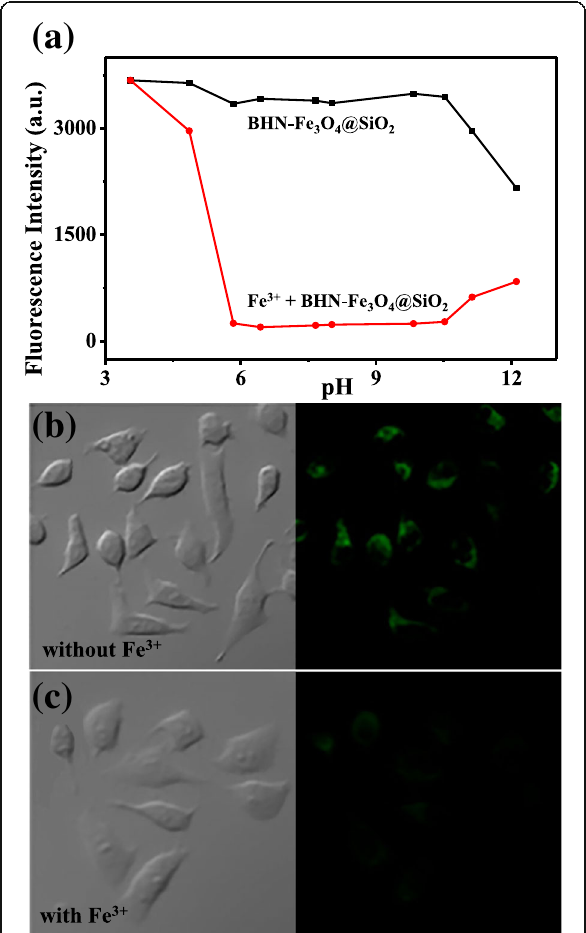
Fig. 5 a Fluorescence intensities of BHN-Fe 3 O 4 @SiO 2 and Fe 3+ -BHN- Fe 3 O 4 @SiO 2 at various pH values at room temperature. CH 3 CN/H 2 O 1:1, λ ex =415 nm. b Bright field image and fluorescence image of the HeLa cells with BHN-Fe 3 O 4 @SiO 2 . ( c ) Bright field image and fluorescence image of the HeLa cells with BHN-Fe 3 O 4 @SiO 2 and Fe